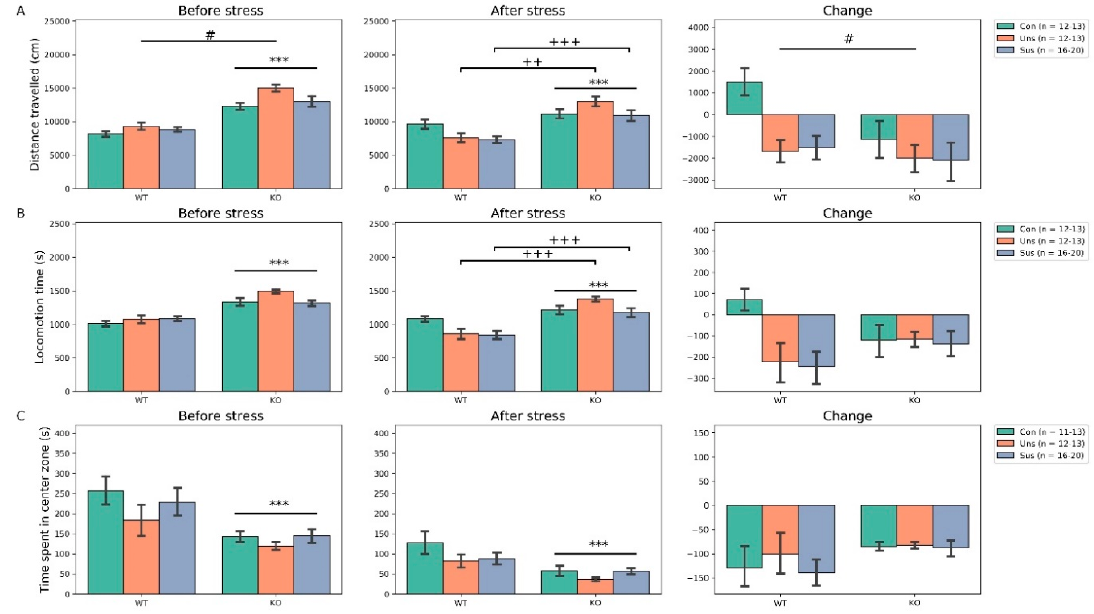
Figure 2. Effects of social defeat on locomotor activities. ( A ) Distance traveled, ( B ) locomotion time, (C) time spent in center zone. *** p < 0.001 for main effect of genotype; # p < 0.05 for main effect of